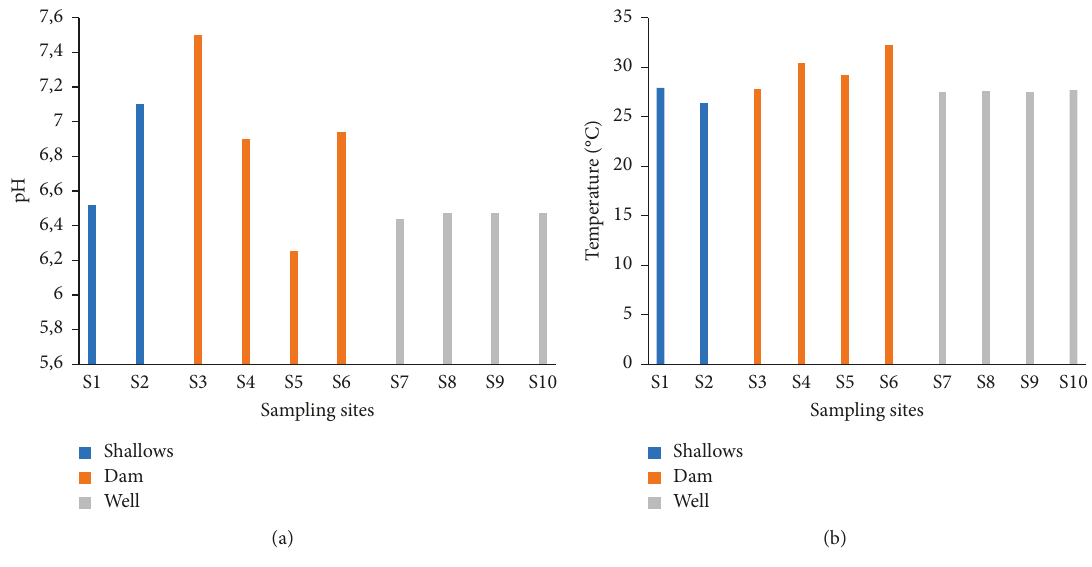
Figure 7: pH (a) and temperature (b) of irrigation water. Table 3: Averages of physicochemical parameters according to sampling